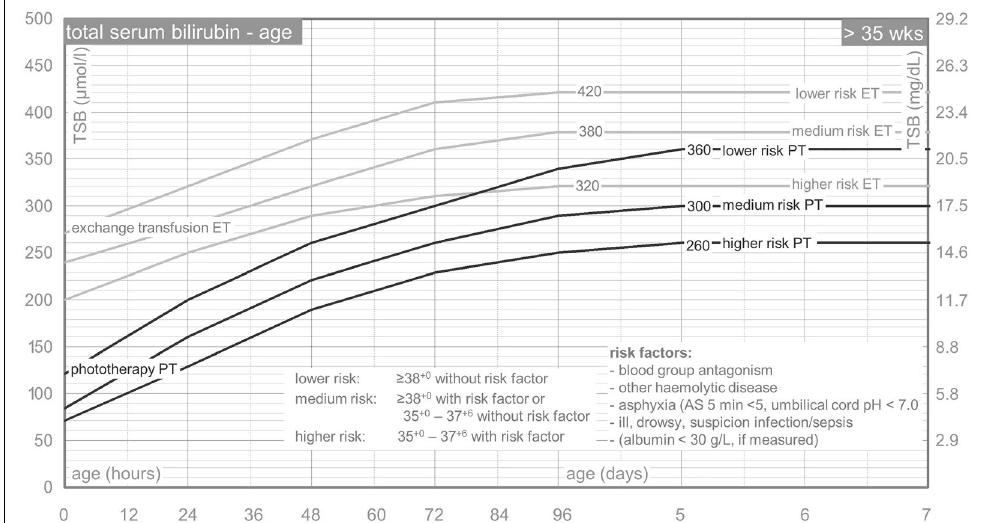
Figure 1. Phototherapy and exchange transfusion thresholds for neonates born after more than 35 weeks of gestation. TSB total serum bilirubin, PT phototherapy, ET exchange transfusion, AS Apgar score. Translated from Dutch. The Dutch nomogram is available at: http:// babyz ietge el. nl/ kinde rarts/ hulpm iddel en/ diagn ostiek/ bilic urve3 5wkn.